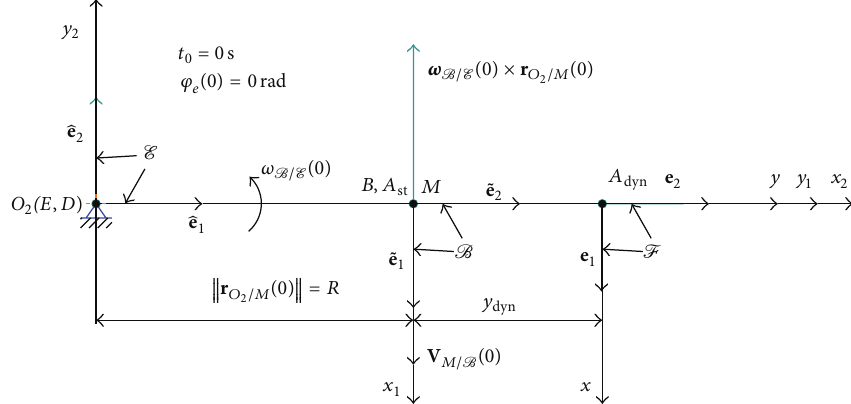
Figure 11: The computational scheme for initial conditions